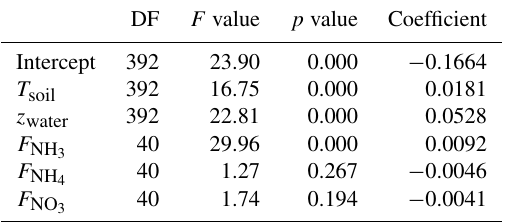
DF F value p value